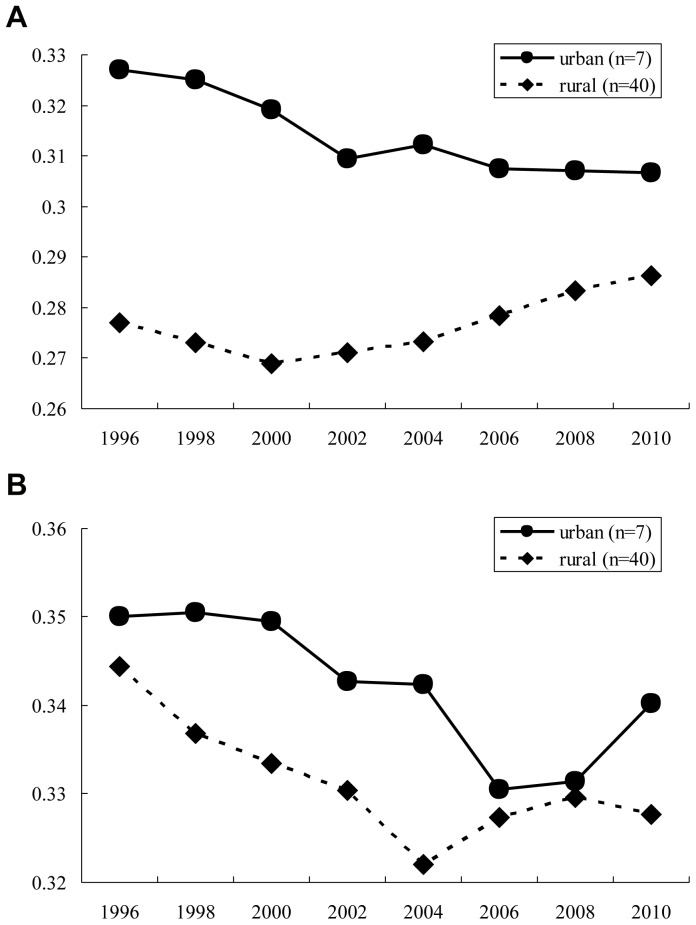

Figure 4-a Mean Gini coefficients of all physicians in intra-prefectural distributions: Prefectures were classified into urban and rural according to the population density.
Figure 4-b Mean Gini coefficients of pediatricians in intra-prefectural distributions; Prefectures were classified into urban and rural according to the population density.